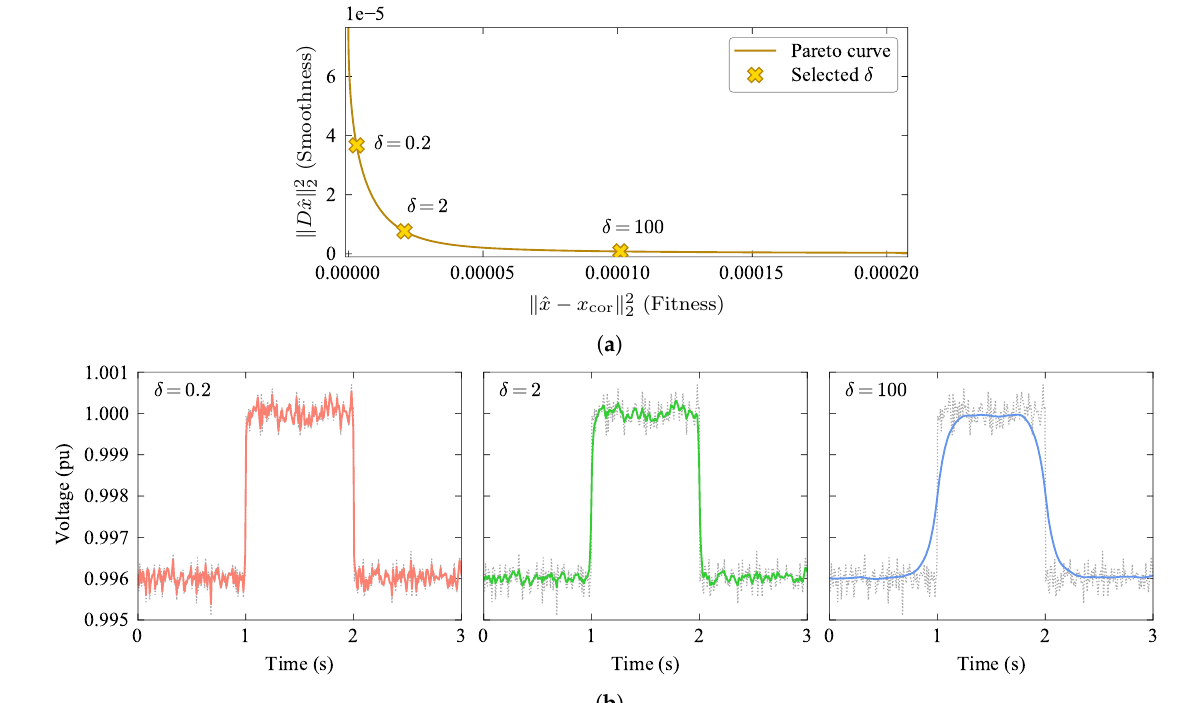
Figure 7. Results of filtering the corrupted synthetic signal 1 through quadratic smoothing. ( a ) Pareto curve. ( b ) Estimated signals representing under-filtering ( δ = 0.2), optimal filtering ( δ = 2) and over-filtering ( δ = 100).